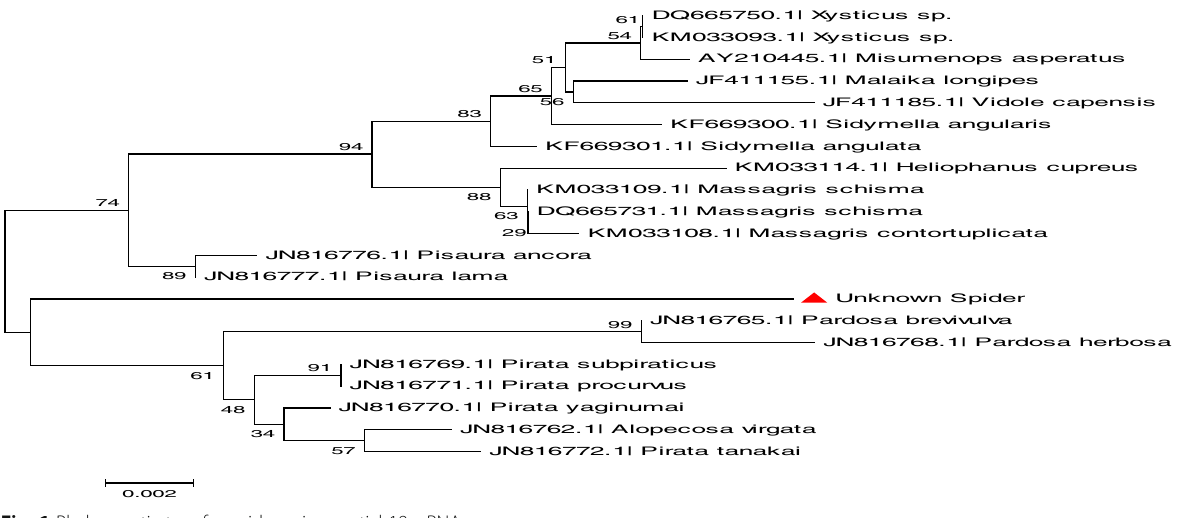
Fig. 1 Phylogenetic tree for spider using partial 18s rRNA gene sequence